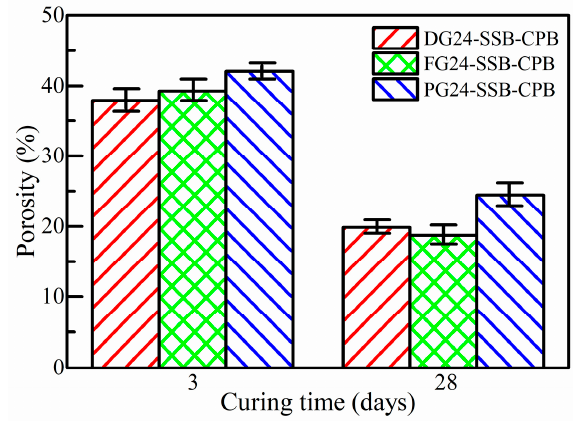
Figure 11. MIP test results for hardened SSB-CP with di ff erent gypsums.